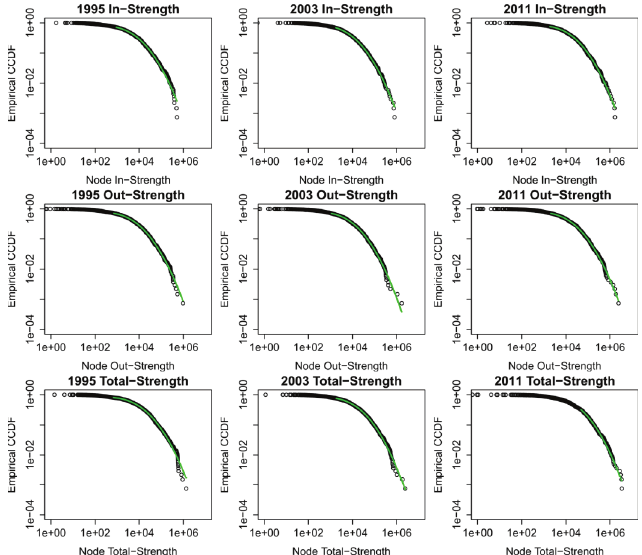
Fig 7. Empirical counter-cumulative distribution functions of in-strength, out-strength, and total- strength for selected years. For the selected years 1995, 2003, and 2011, the first row has the in-strength distributions while the second row and the third row have the out-strength and total-strength distributions respectively. The observed data are in black circles while the green curve is the fitted log-normal distribution.